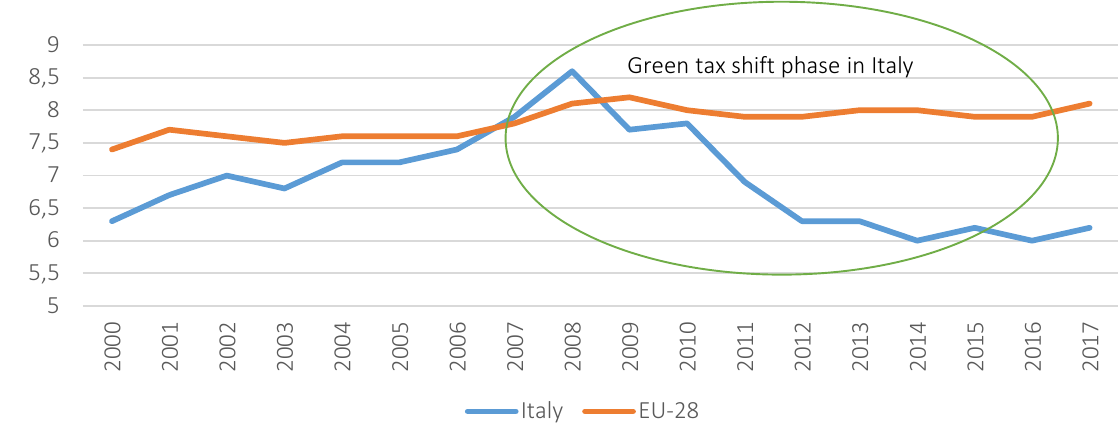
Figure 4. Labor tax/environmental tax